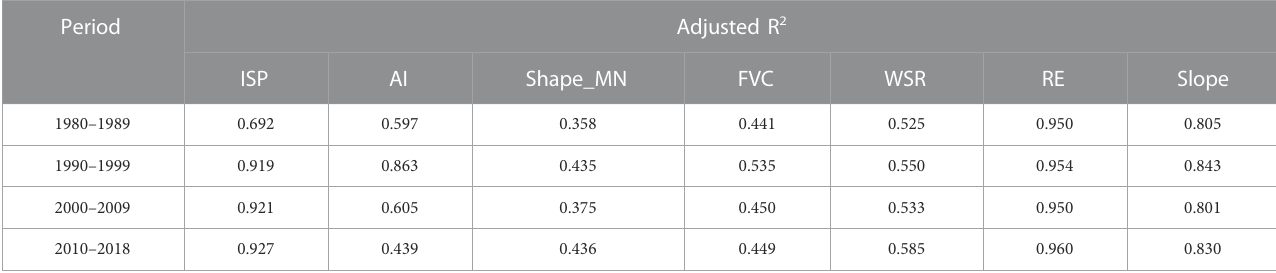
TABLE 4 GWR results of the in fl uencing factors of urban fl ooding in the GBA. Period Adjusted R 2 ISP AI Shape_MN FVC WSR RE